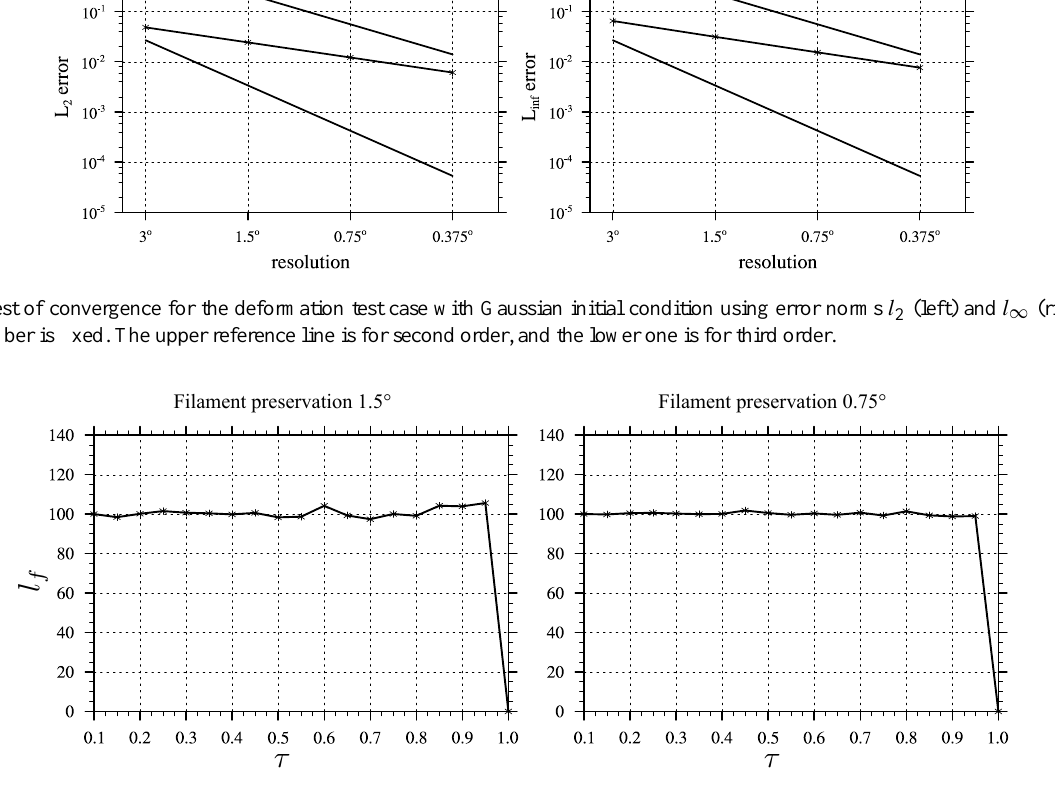
Figure 9. Diagnostics for filament preservation, l f , for the model grid resolution 1 . 5 and 0 . 75 ◦